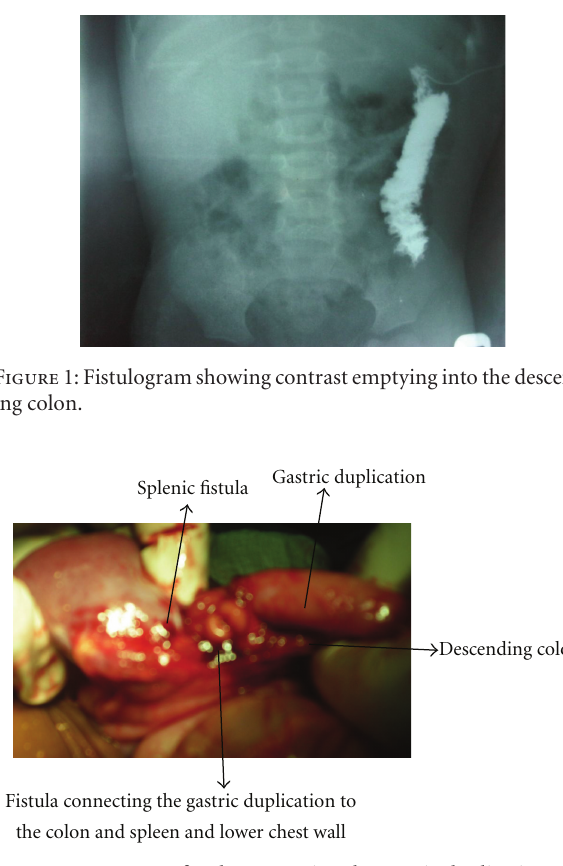
Figure 2: Common fistula connecting the gastric duplication with the descending colon, spleen (and splenic erosion), and the strand of pancreatic